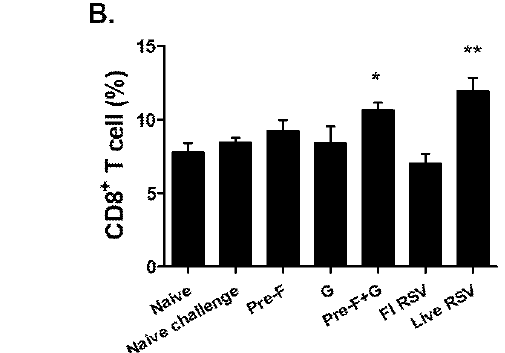
Figure 5. CD4 + and CD8 + T cell counts in lung. To isolate the CD4 + and CD8 + T cells in the lung, lung cells were stained with surface markers (CD3, CD4, and CD8) and analyzed with BD Accuri software ( A , B ). Data were acquired on an individual basis from each group (n = 6) and presented as percentages among the CD3 + T cells. Pre-F+G VLP-immunized mice showed higher levels of CD4 + and CD8 + T cells compared to naïve control mice (* p < 0.05, ** p <